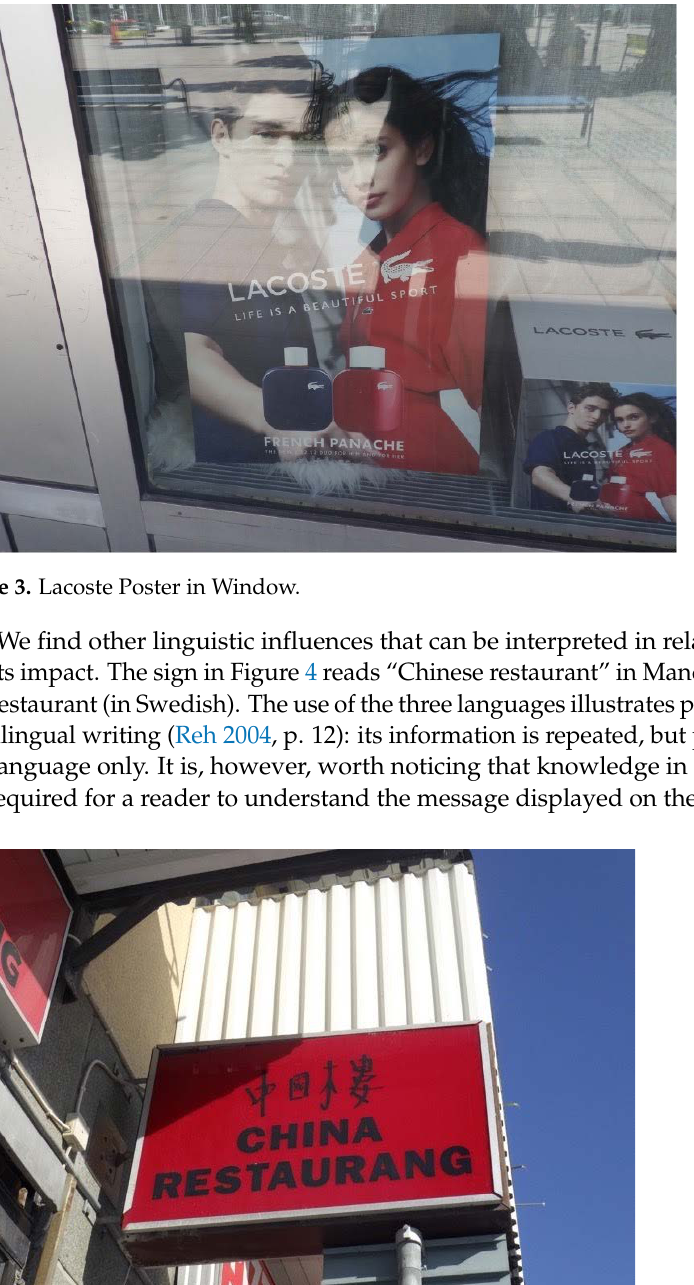
Figure 2. Poster for City Party .